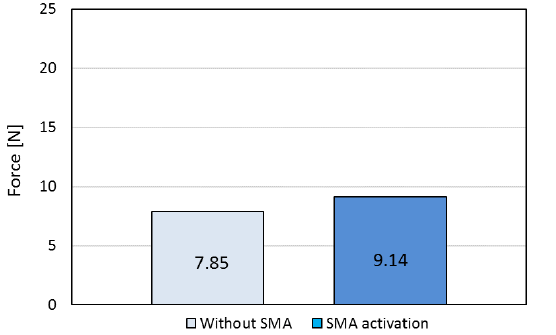
Fig. 20. Harmonics of the side forces – II h force pulsation